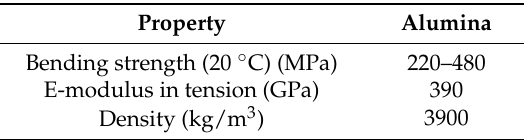
Table 7. Material properties of alumina (as provided by